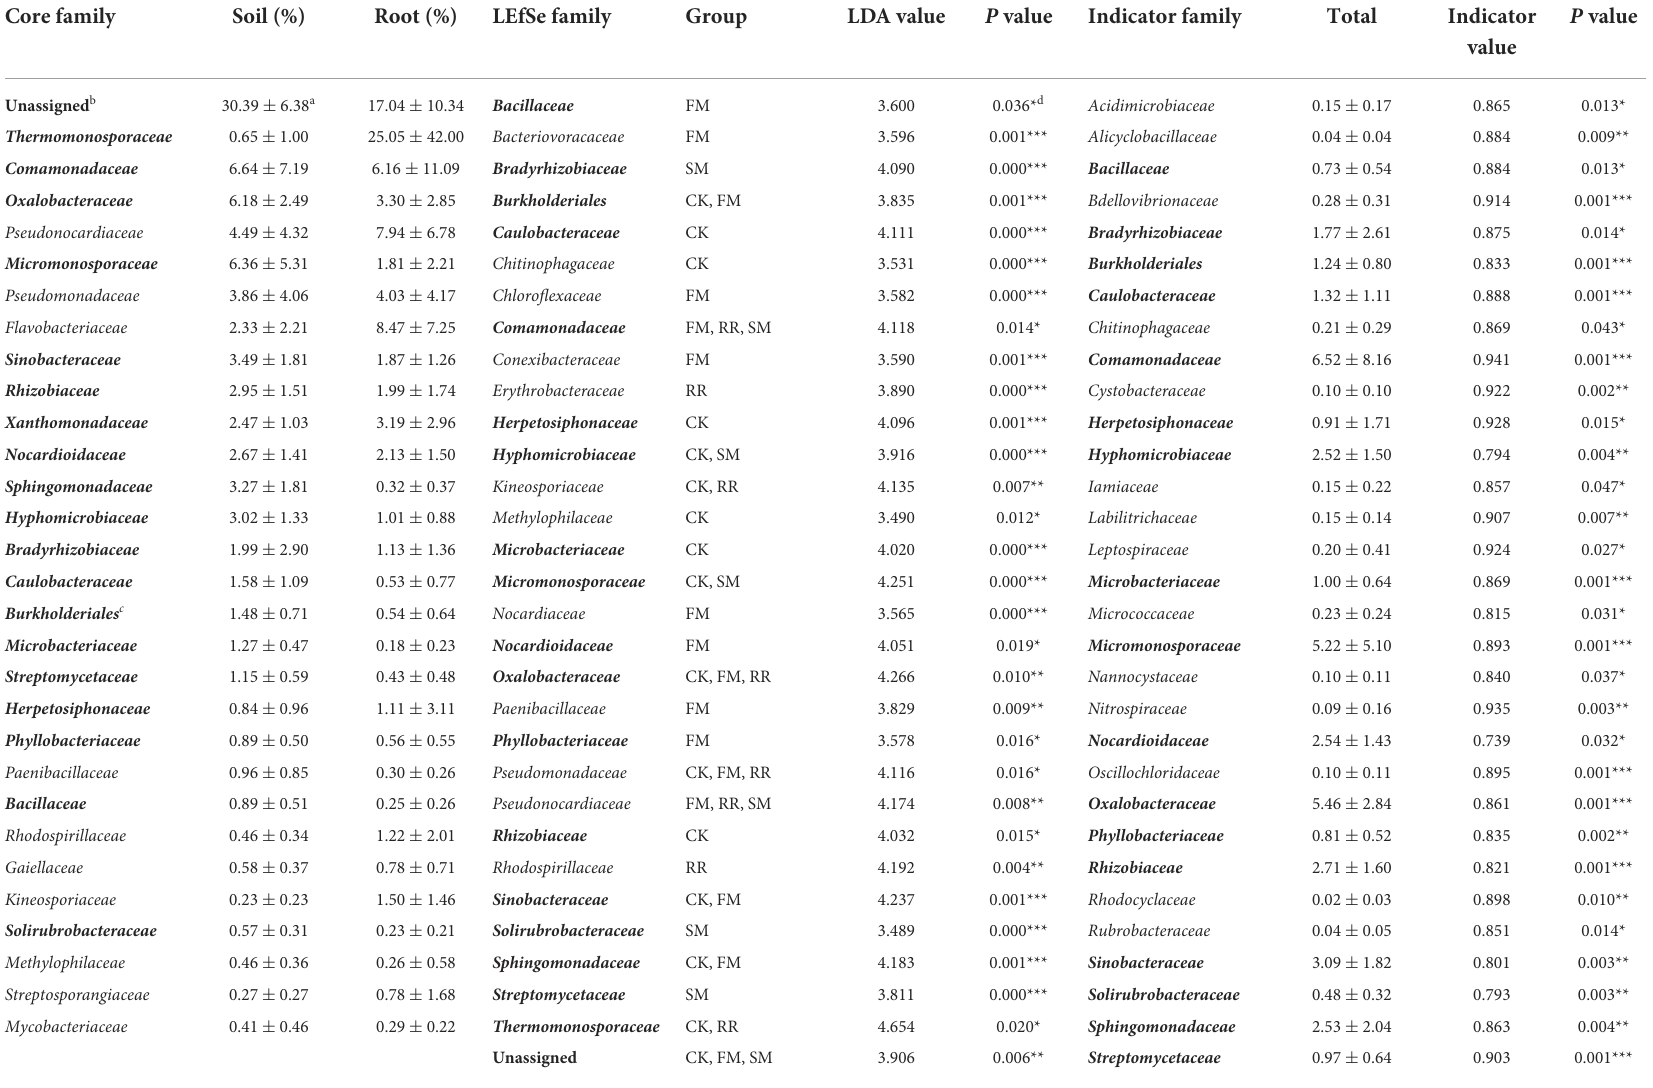
TABLE 2 Results of indicator families, core families, and the linear discriminant analysis (LDA) effect size (LEfSe)